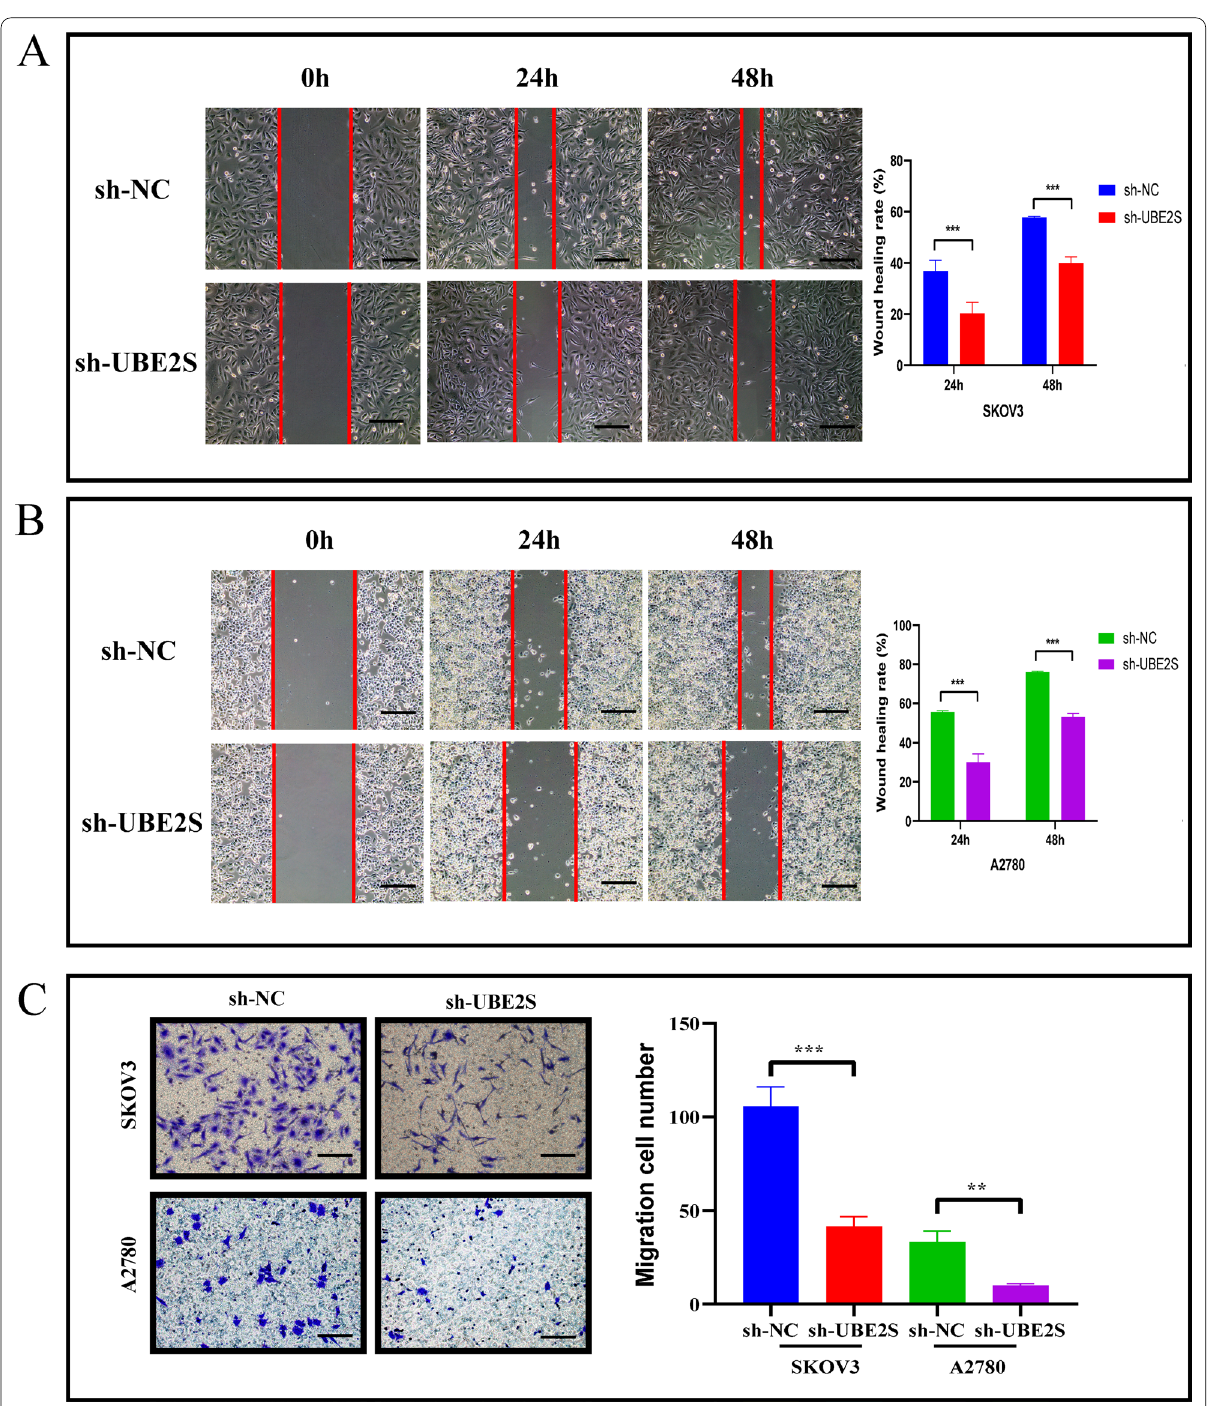
Fig. 9 The effect of UBE2S gene knockdown on the migration of OV cells. A Wound-healing assay results and statistics of SKOV3 cell line after cell transfection. B Wound-healing assay results and statistics of the A2780 cell line after cell transfection. The wound-healing rate was measured at 0, 24, and 48 h, which represented the migration capacity. C Transwell assay results and statistics of OV cells after cell transfection. The number of migrating cells was measured at 24 h, which represented the ability to